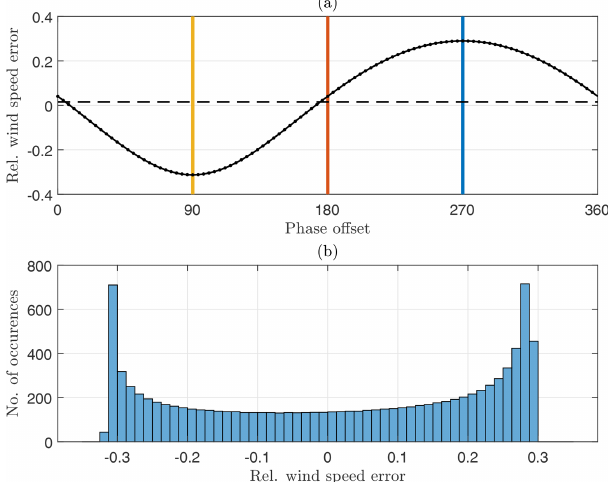
Figure 4. Beam geometry of VAD scanning wind lidar under in- fluence of pitch motion with oscillation frequency f p = f s = 1Hz and amplitude A = 10 ◦ . The panels show (a) instantaneous pitch angles, (b) zenith angles, (c) measurement elevations, and (d) cor- responding figures of eight. Colors represent different phase shifts between lidar prism angle and pitch motion corresponding to the colors in Fig. 3. The figure of eight for fixed lidar is also shown (black dashed).The nominal measurement elevation is 100m.